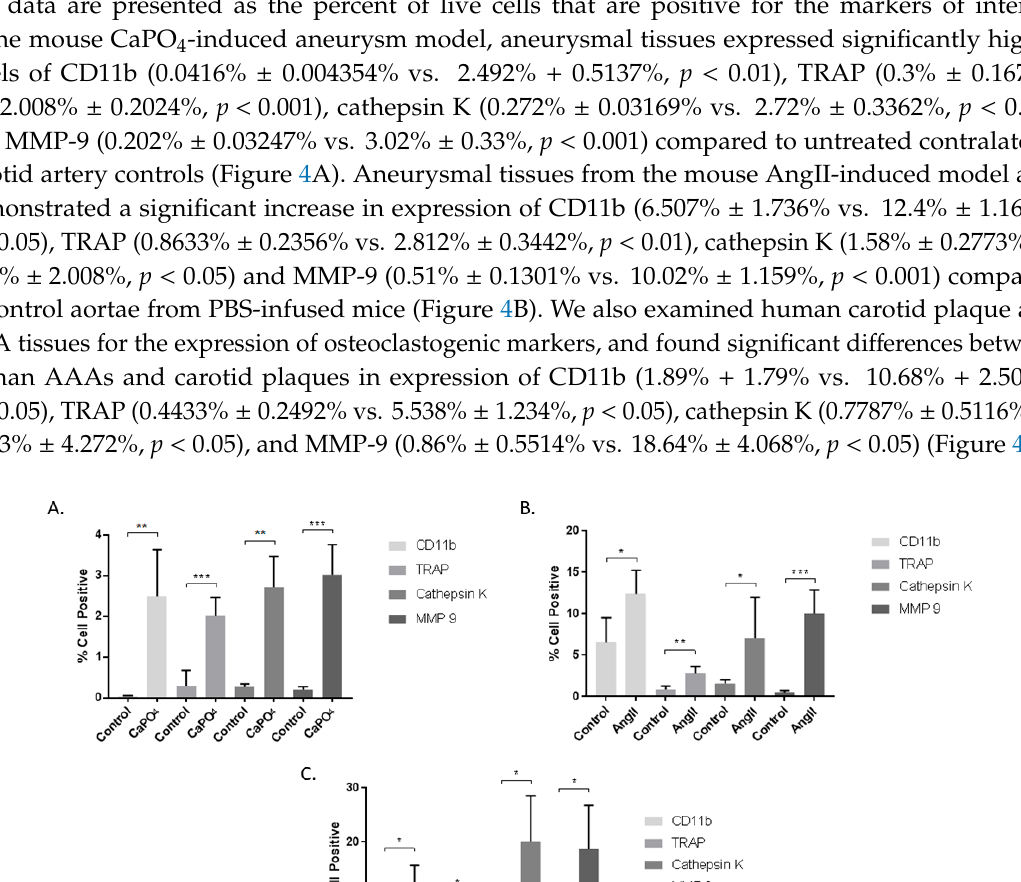
Figure 3. Mouse CaPO 4 and AngII-induced aneurysms. ( A , B ) Representative images of mice treated via perivascular application of CaPO 4 or subcutaneous administration of AngII, respectively. Black arrows indicate aneurysmal vessels. ( C , D ) CaPO 4 and AngII treatment resulted in significant vessel dilation compared to control vessels ( n = 5). In the CaPO 4 model ( C ), the contralateral carotid arteries served as controls ( n = 5), and PBS-only treated mice served as controls for the AngII model ( n = 3)